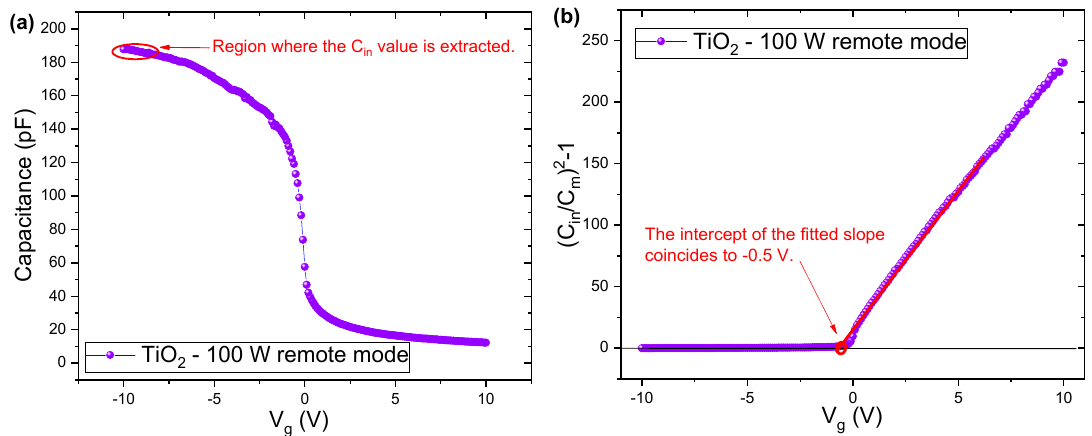
Figure 10. Nicollian and Brews [75] method used to calculate the capacitance of the insulator ( C in ), flat-band voltage ( V fb ) and fixed insulator charges ( Q f ). ( a ) C-V curve showing the extract region of the C in value, and ( b ) shows the typical V fb extraction through the intercept of the fitted slope.